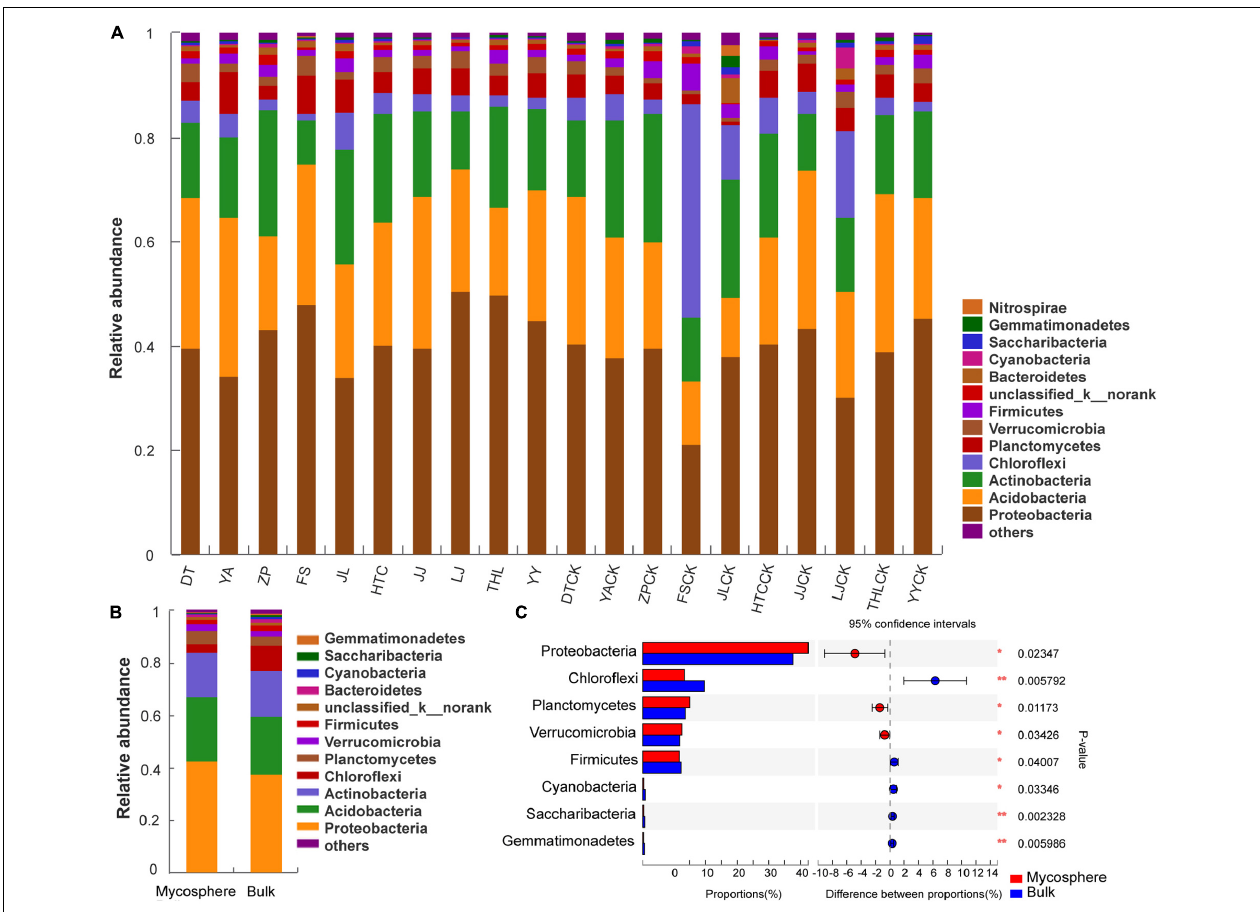
FIGURE 3 | Comparison of phyla between mycosphere and bulk soil. (A) The abundances of phyla of each site. (B) Comparison of the average abundance of phylum in mycosphere and bulk soil. (C) Significant differences among the abundances of phyla between mycosphere and bulk soil. Significant differences by * p < 0.05 and ** p <